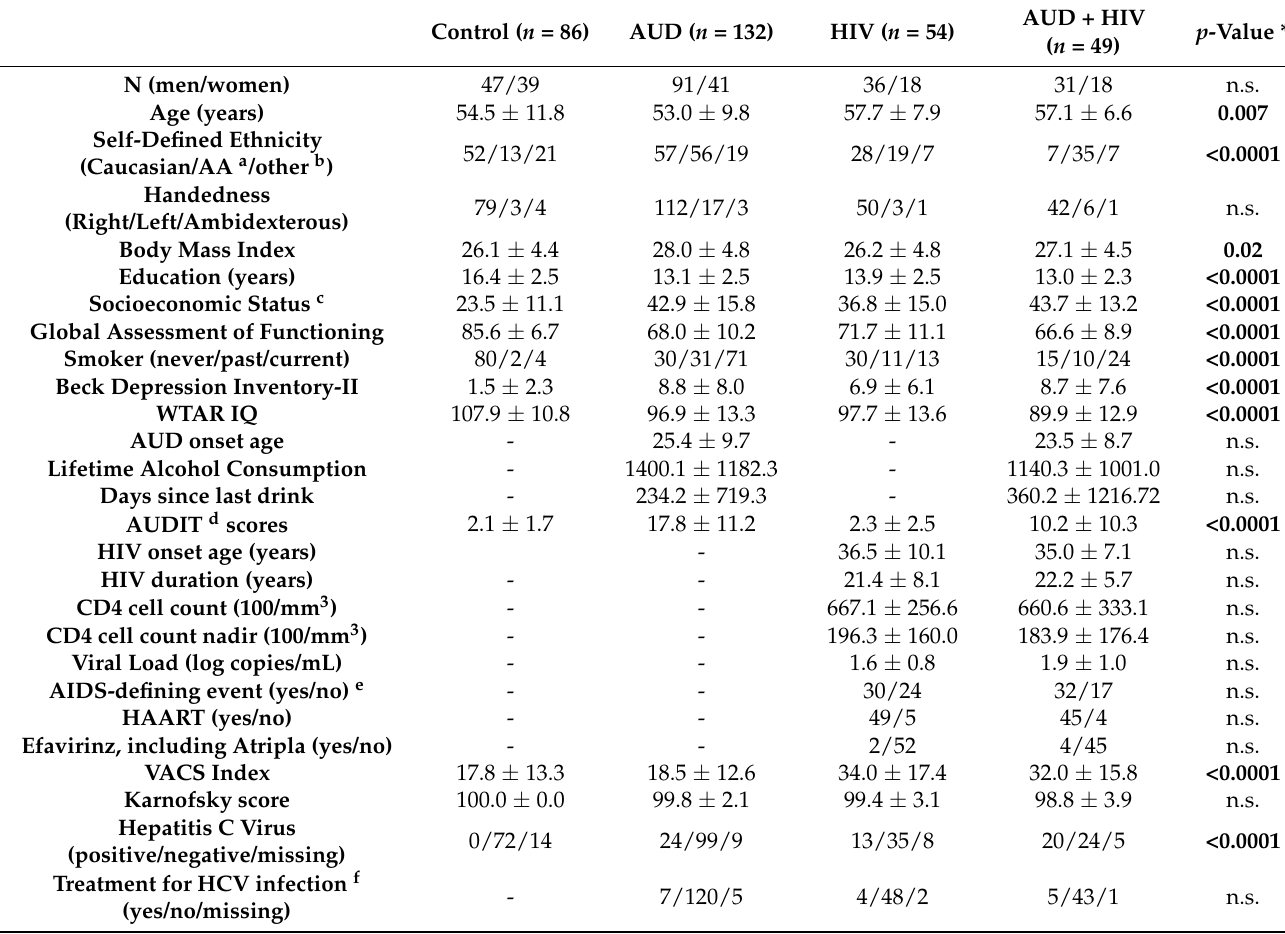
Table 1. Demographic characteristics of the 4 study groups: mean ± SD/frequency